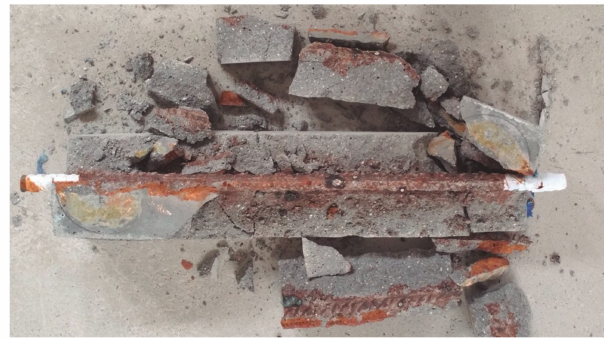
Figure 6. Photo taken after breaking the M1-reinforced mortar specimen at the end of the corrosion